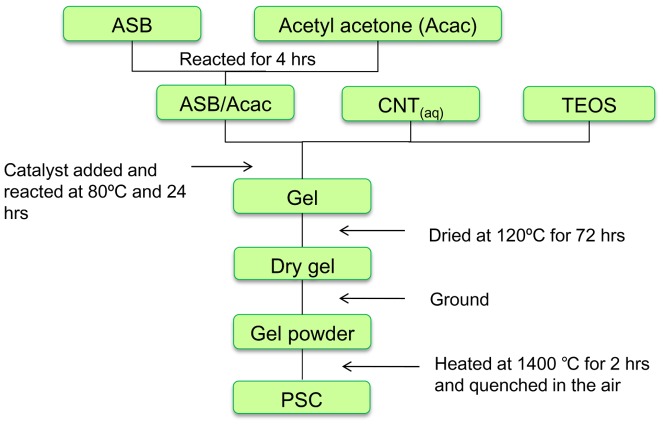
Schematic diagrams of the preparation of PSC.ASB  =  aluminum sec-butoxide; CNT  =  calcium nitrate; TOES  =  tetraethyl orthosilicate; PSC  =  partial stabilized cement.